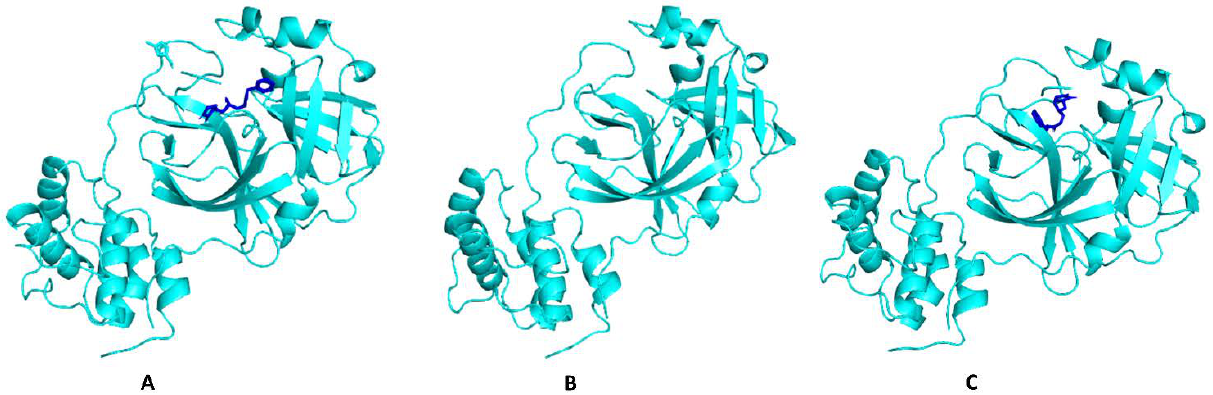
Figure 8. (A ) Original 6LU7 (Mpro with bound N3), ( B ) Mpro (6LU7) without N3, and ( C ) N3 re-docked with